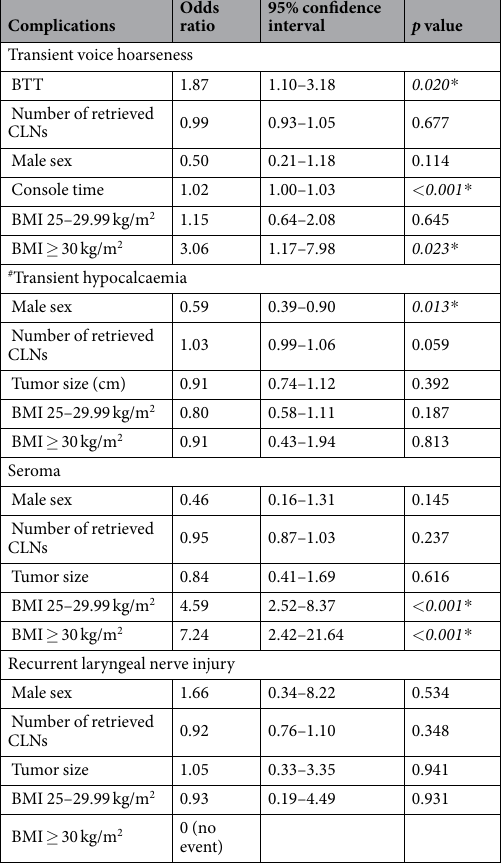
Table 3. Multivariate analysis of risk factors associated with common thyroidectomy complications BMI, body mass index; BTT, bilateral total thyroidectomy; CLN, central lymph node; # Bilateral total thyroidectomy patients only; * statistically significant at p <